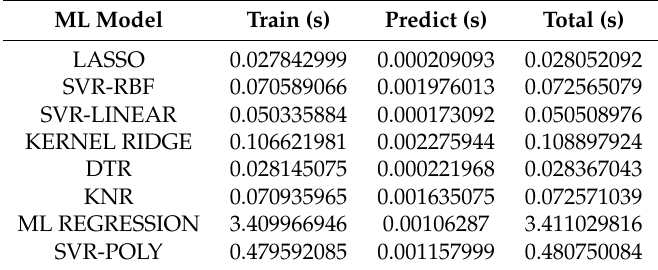
Table 2. Execution time of the applied ML models per iteration. in terms of time of training, predict and total time which are sum of the train plus predict